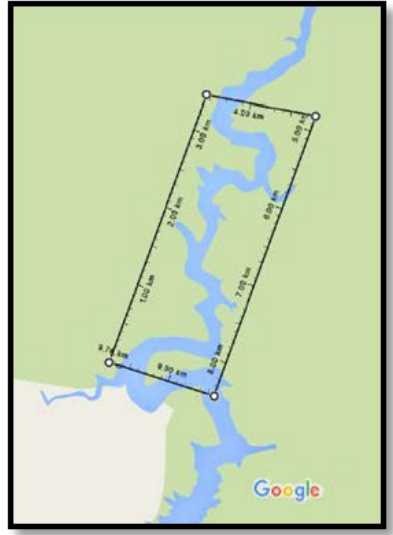
Figure 1. The location of Research Study at Hulu Sungai